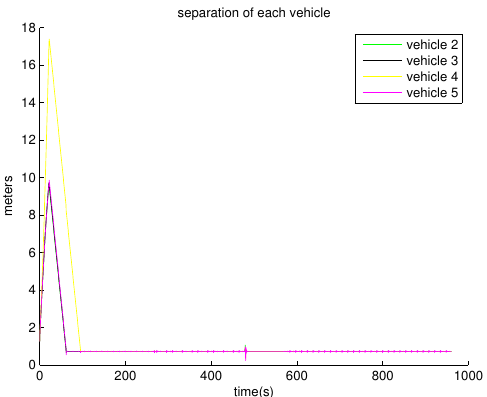
Figure 9. This figure shows the separation between every neighboring truck (scenario 2). γ = 1.01 is used. No Gaussian noise is used. See that the deviation of every truck’s separation decreased, compared to the case where Gaussian noise is used (Figure